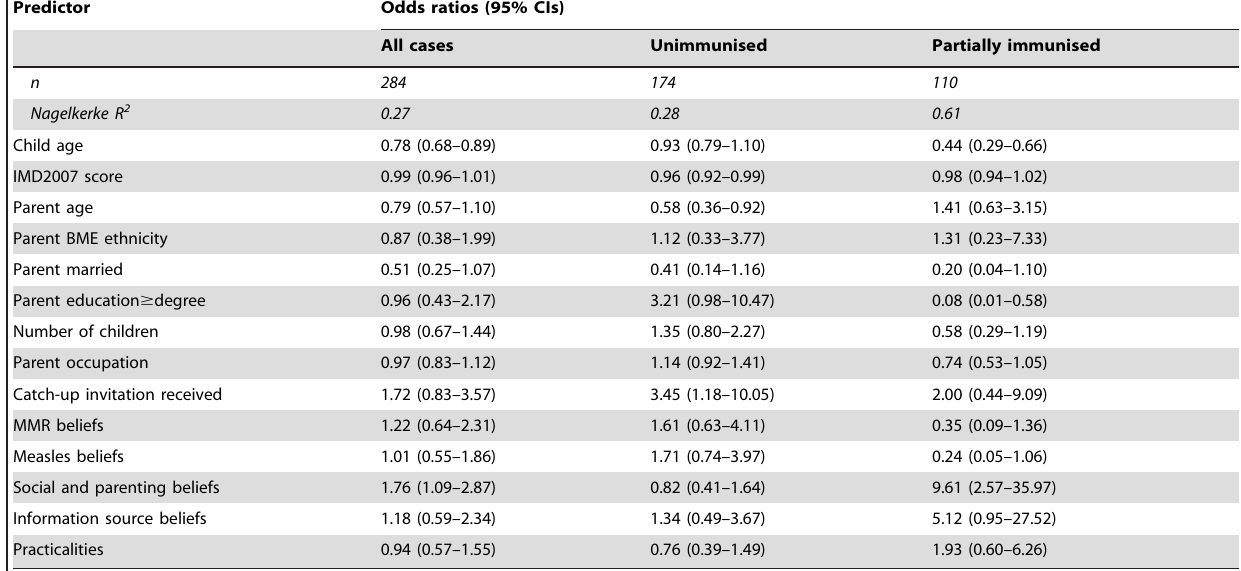
Table 4. Independent predictors of catch-up MMR